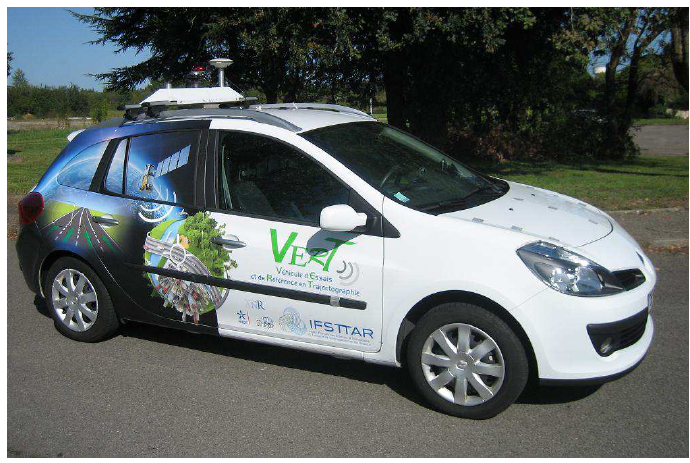
Figure 5. The experimental vehicle of